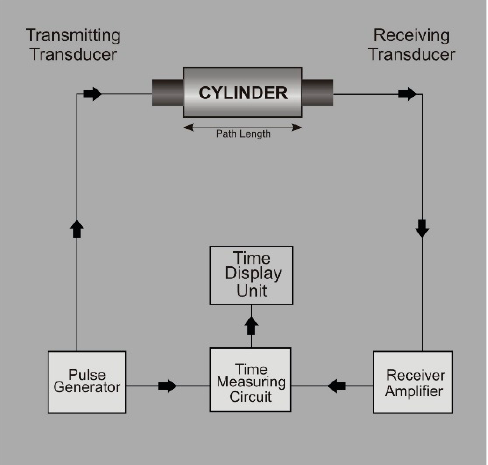
Figure 6. Ultrasonic pulse velocity working flow diagram [43].